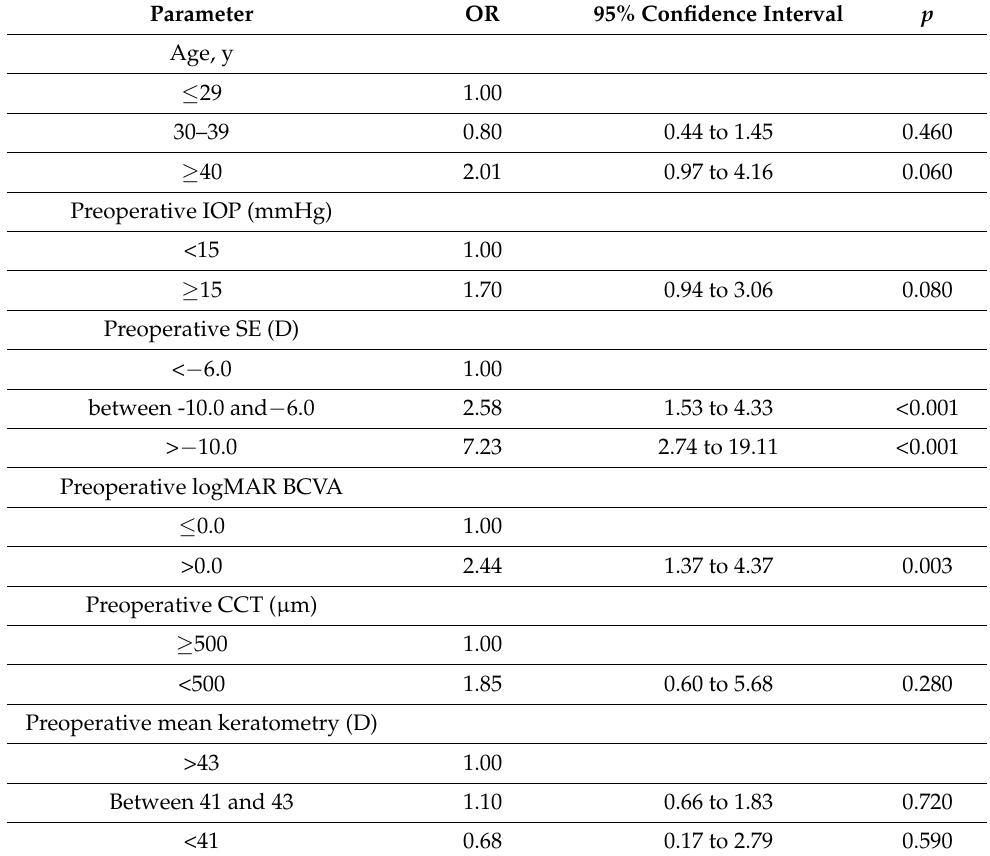
Table 5. Multivariate logistic regression analysis to assess the predictor variables of low postoperative